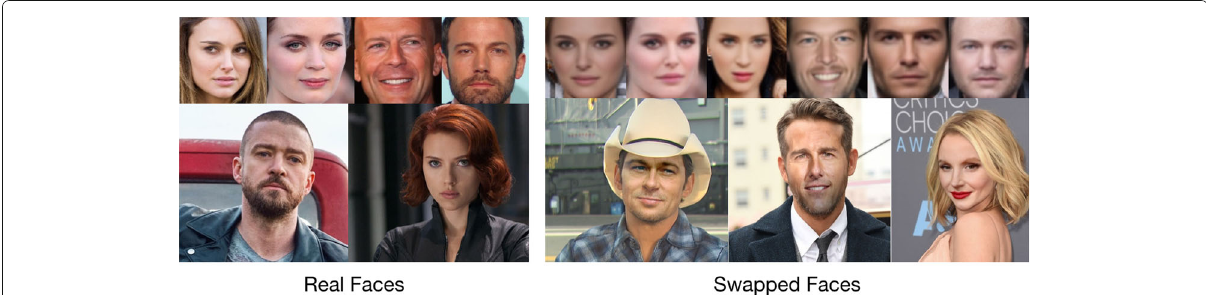
Fig. 1 Real and swapped faces in our dataset. Top row right: Auto-Encoder-GAN. Bottom row right: Nirkin’s method